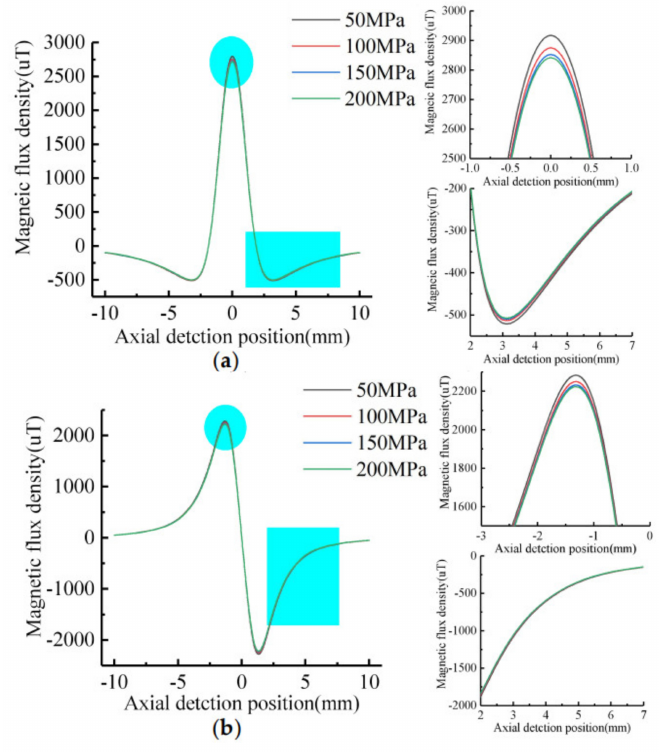
Figure 15. Signal characteristics of defects with different stress: ( a ) Tangential signal; ( b ) Normal signal.